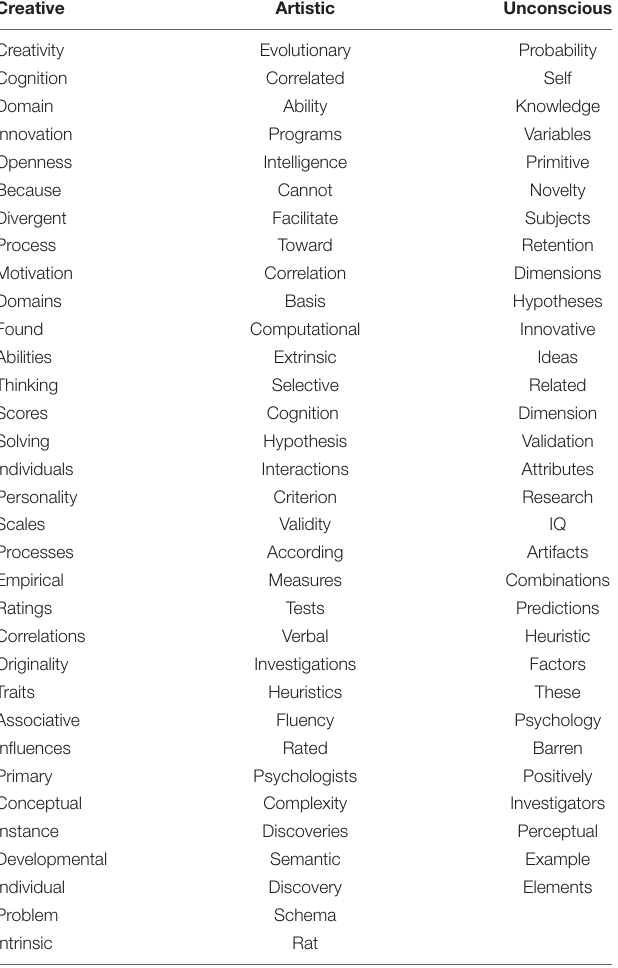
TABLE 3 | Top 100 creativity corpus keywords (Jordanous,